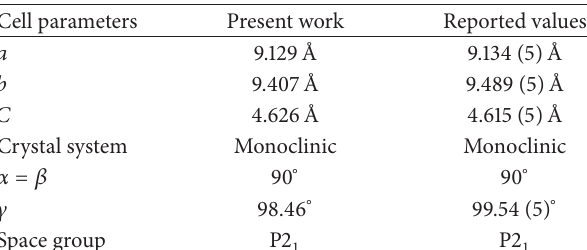
Table 1: XRD data of LSP